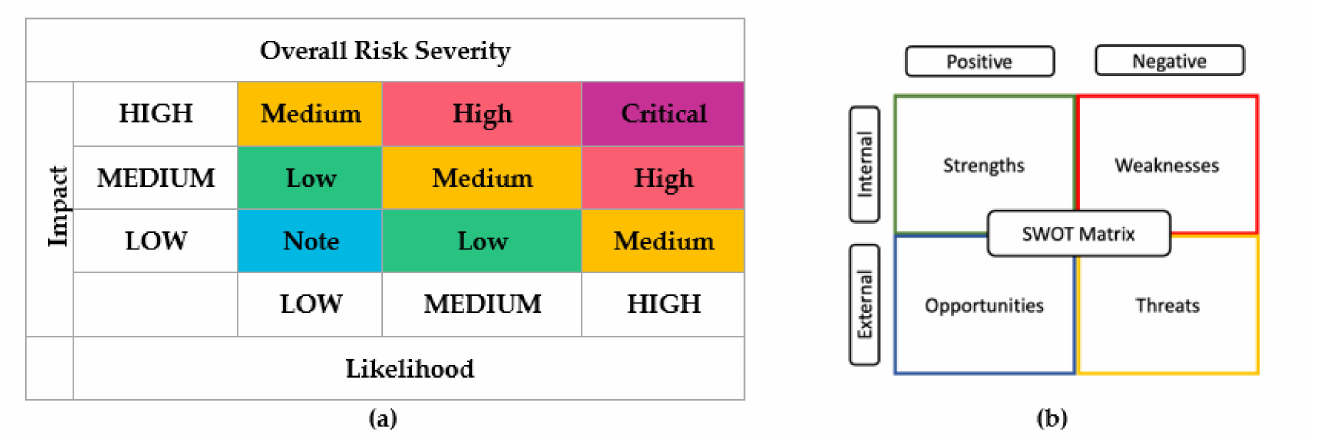
Figure 2. Risk estimation matrix: ( a ) OWASP Risk Rating Methodology; ( b ) SWOT